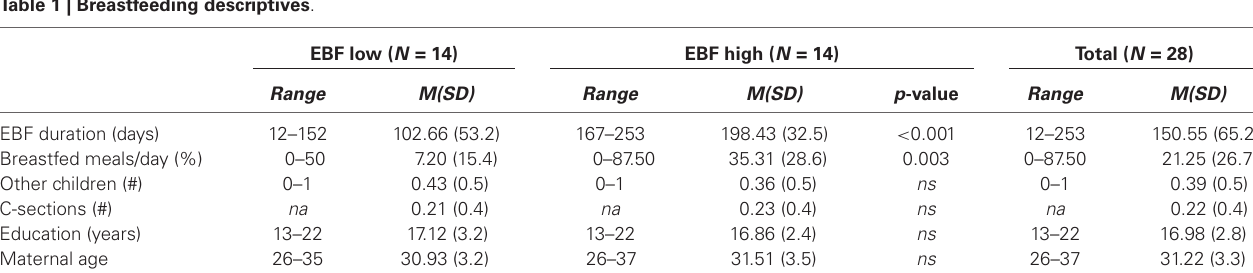
Table 1 | Breastfeeding descriptives